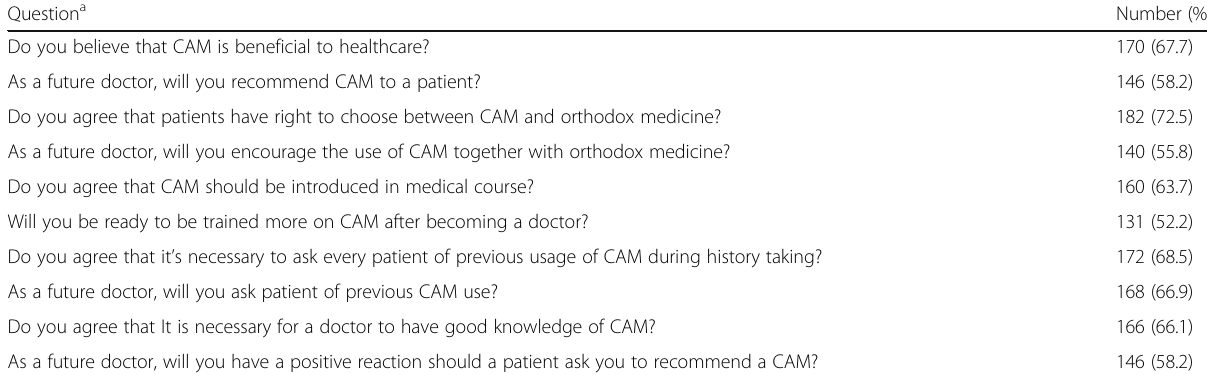
Table 7 Participants ’ attitude towards complementary and alternative medicine (CAM) Question a